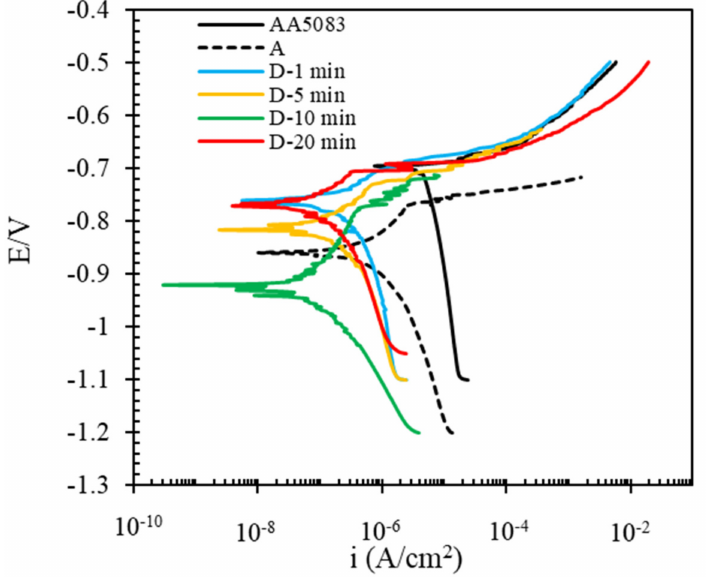
Figure 8. Polarization curves of coated and uncoated AA5083 samples in 3.5 wt.% NaCl corrosive media. The samples were prepared by pretreatments of washing at different deposition times (1, 5, 10, and 20 min) for the D Pretreatment Method.